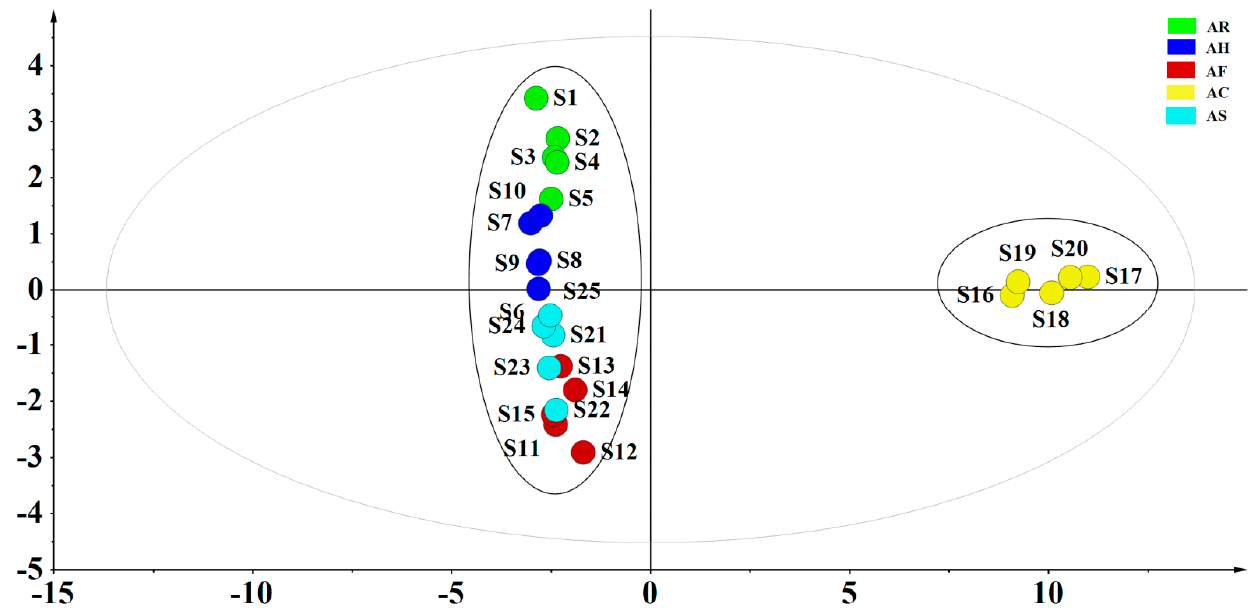
Figure 3. The principal component analysis (PCA) scores scatter plot of different parts of Abelmoschus manihot .